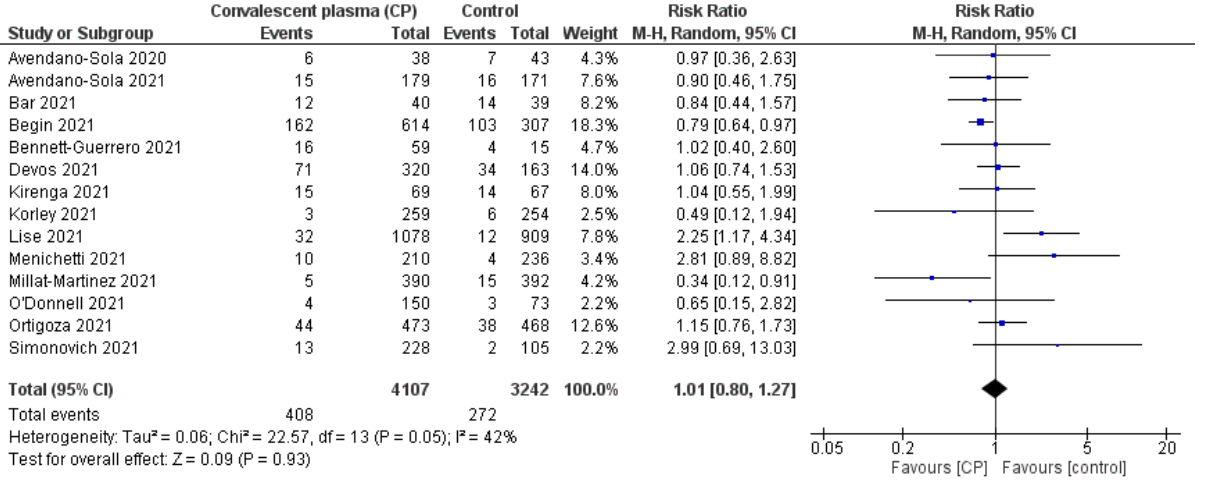
Figure 4. Comparison of adverse event caused by CP transfusion and control groups [15,16,18,20– 22,27–29,34,39–41,44]; ( ) RR of individual studies; ( ) RR summary of the comparison.